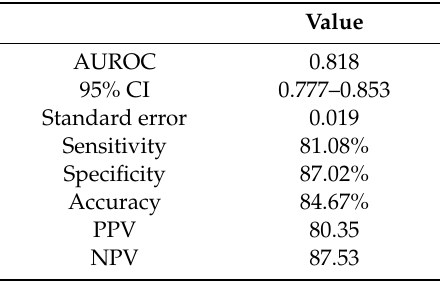
Table 3. The diagnostic abilities of AniScan ECPKA autoantibody